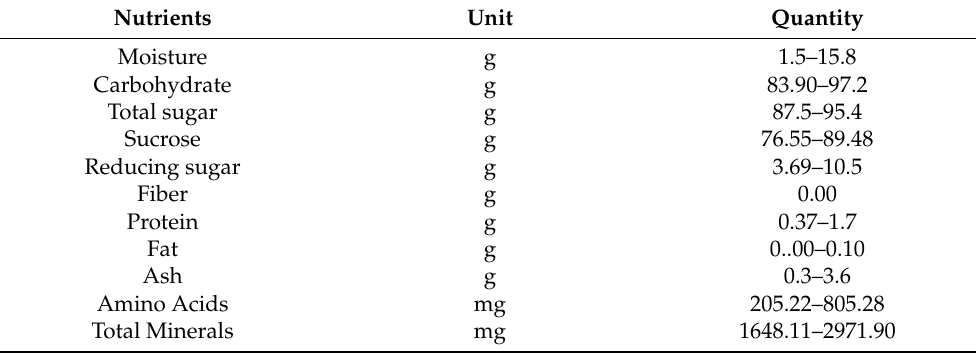
Table 1. General Chemical Composition of NCS